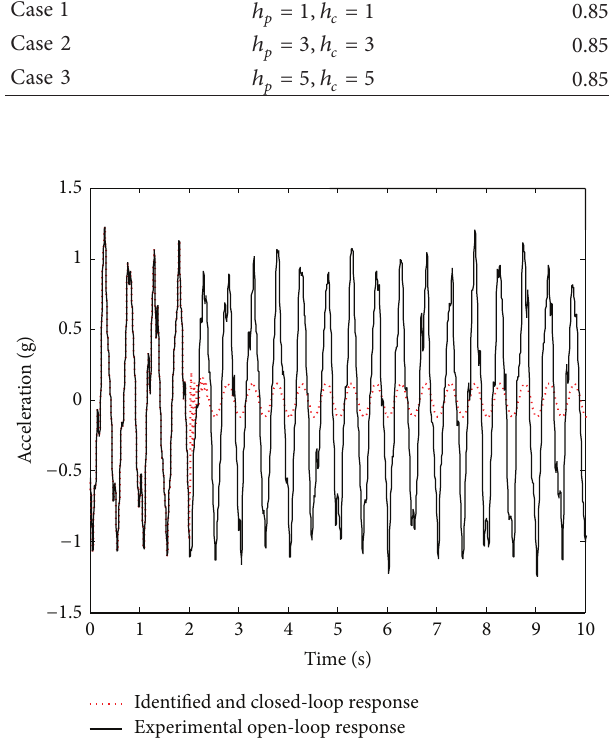
Figure 4: The comparison of open-loop and closed-loop accelera- tions in the time domain for ℎ 𝑝 = 5 , ℎ 𝑐 = 5 .